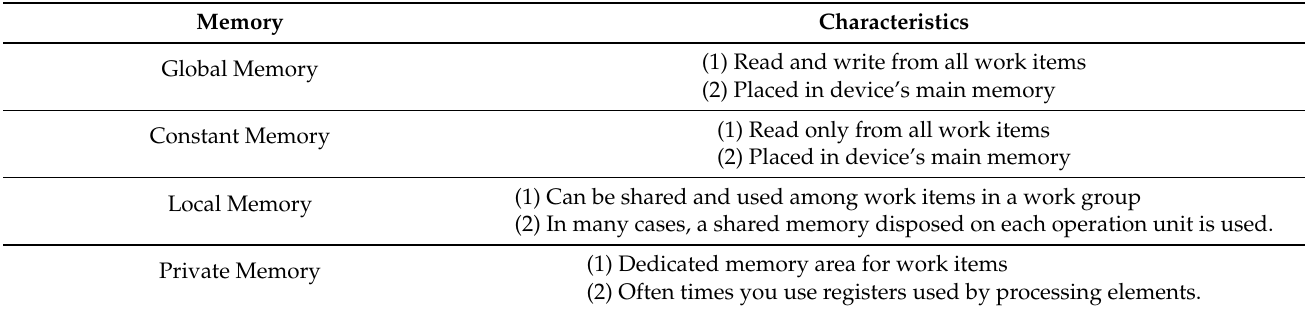
Table 1. OpenCL memory characteristics [14,15].